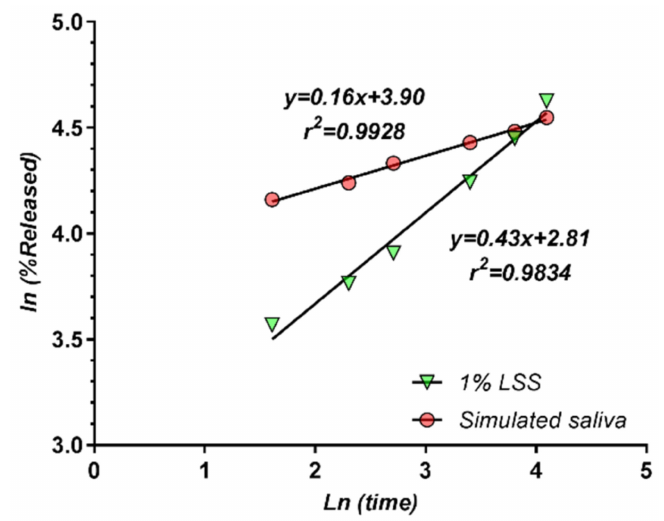
Figure 11. Peppas release model. Fitting of data from 5 min to 60